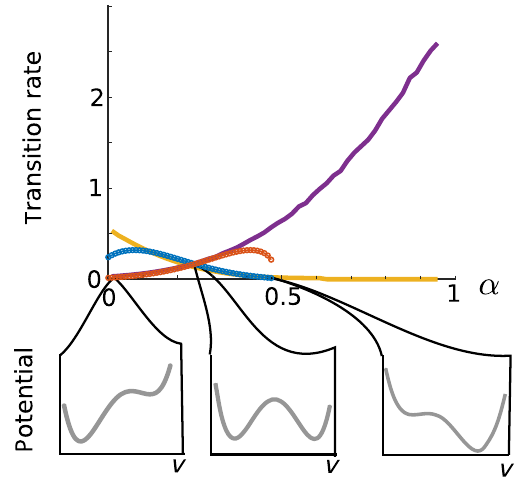
FIG. 10. Comparison of numerical rates of transition from pioneer to rest (yellow) or rest to pioneer (purple) with associated Kramers escape rate formula (A1) (respectively, blue and red) for J ¼ 1 . 5 and σ ¼ 1 . 5 . A very good agreement arises when the equilibria are sufficiently stable (potential wells of U deep enough). Escape rates are largely underestimated whenthe potential becomes too flat (conjectured breakdown arising when the depth becomes of the same order of magnitude as the potential well depth), in which case typical stochastic fluctuation dominates the escape rate compared to the small-noise correction provided by the